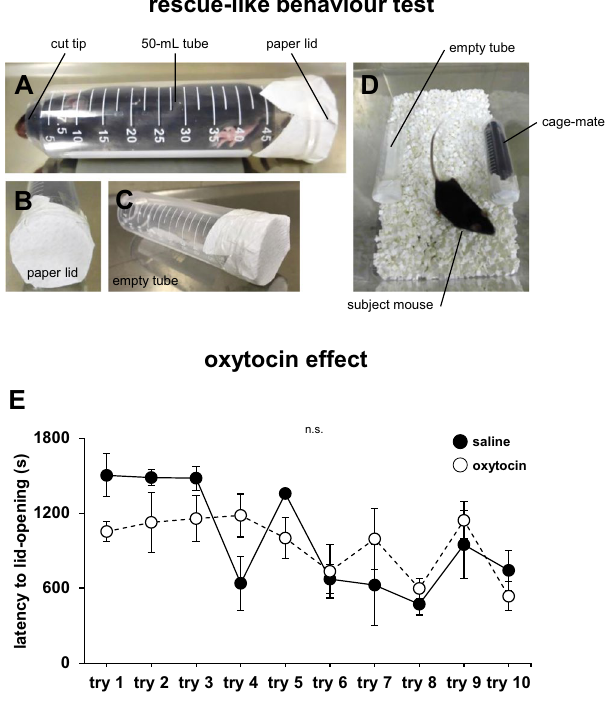
Figure 1. Rescue-like behaviour test and the effect of oxytocin on rescue-like behaviour. ( A ) Sample picture of a mouse waiting for its release from a 50-mL tube. ( B ) A sample image showing the back of a mouse-containing tube covered with a paper lid. ( C ) A sample image showing the back of an empty 50-mL tube covered with a paper lid. ( D ) Sample picture of the rescue-like behaviour test in the new home cage. ( E ) Rescue-like behaviour test for the constrained cage-mate: latency to paper lid-opening in each trial. Data are presented as the mean ± SEM. Statistical significance is represented by asterisks: * p < 0.05. n.s., not significant. The p values were calculated by two-way repeated measures ANOVA. n = 20 animals per